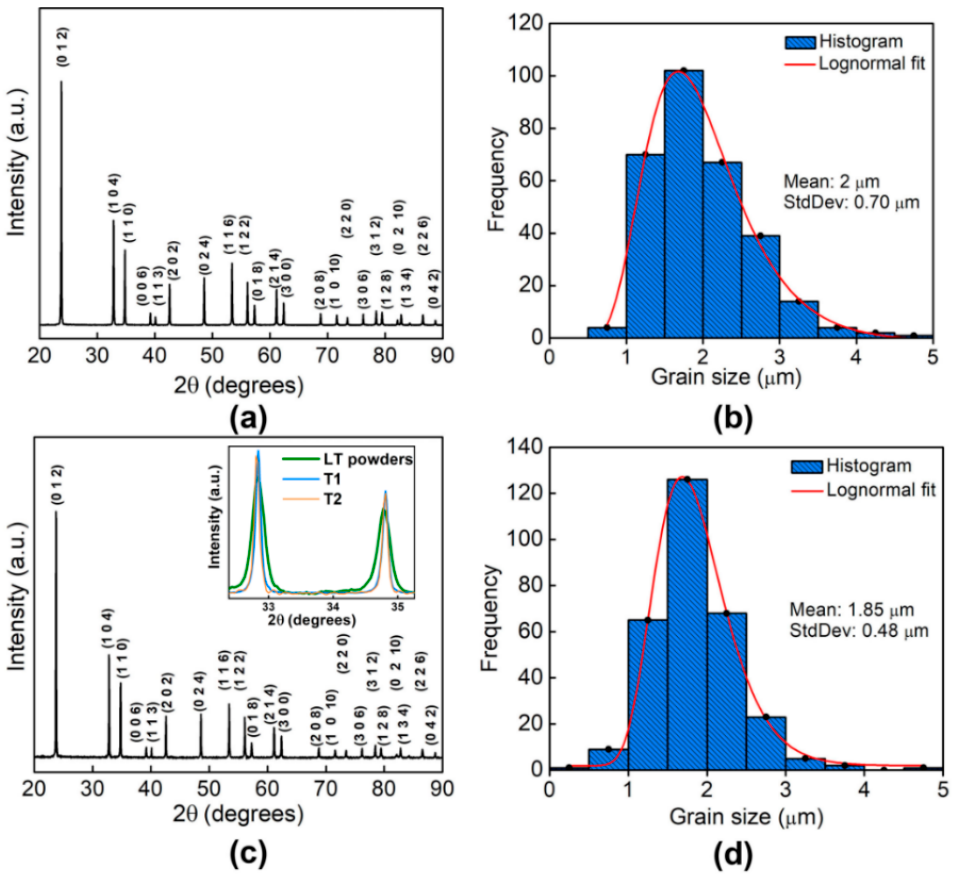
Figure 2. Structural and morphological characterization of the targets: ( a , c ) XRD pattern of T1 and T2, respectively; ( b , d ) grain size distribution of T1 and T2, respectively.